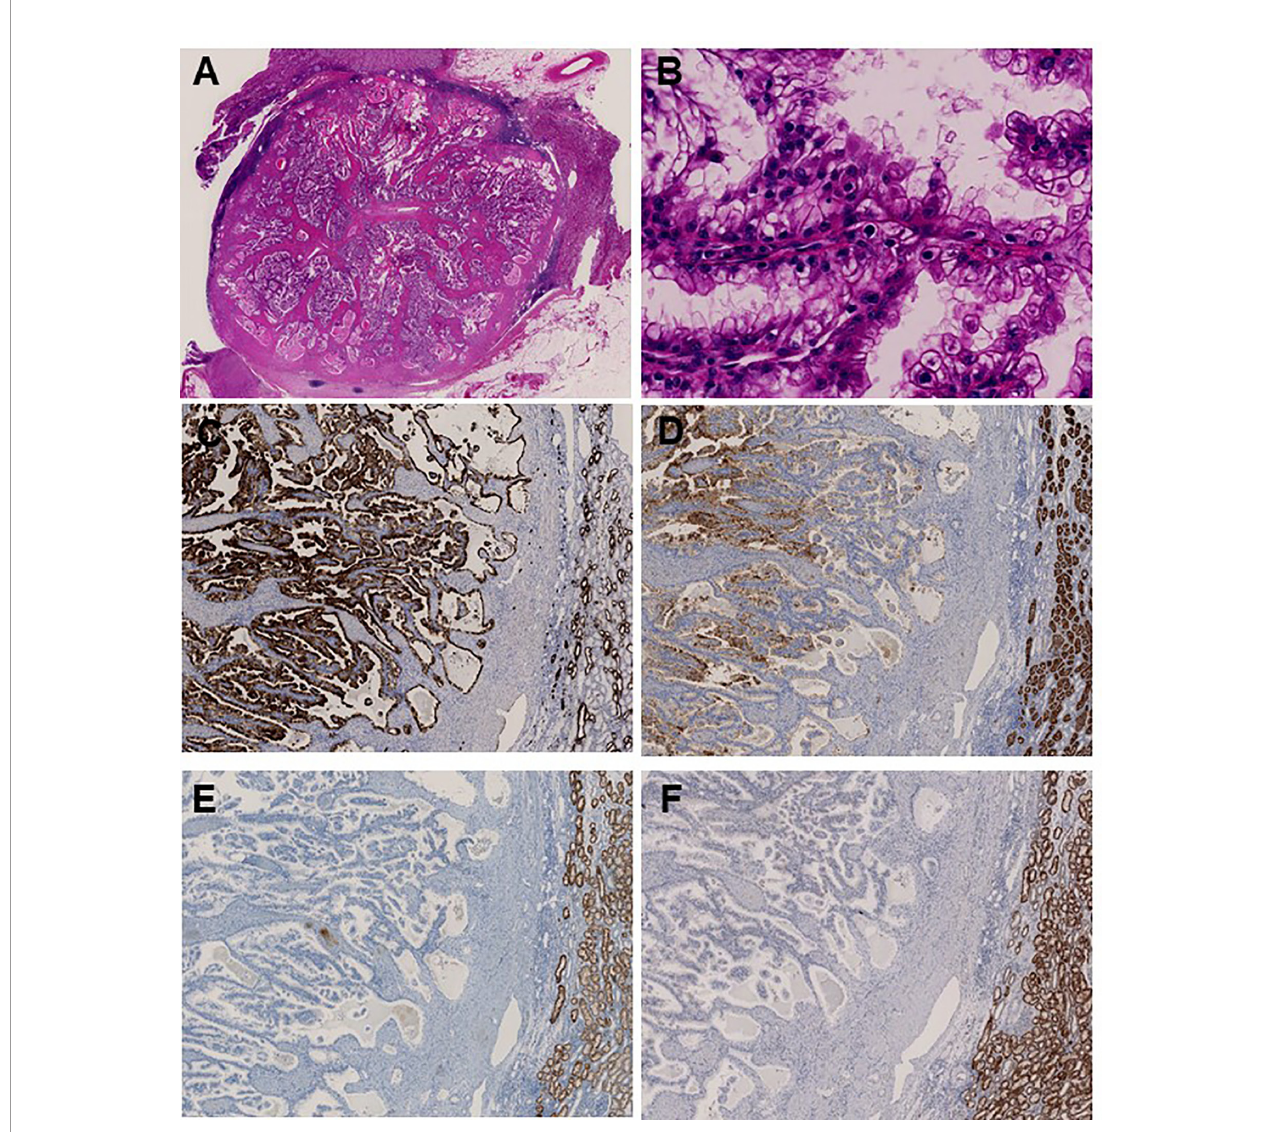
FIGURE 3 | Immunohistochemical analysis identi fi es papillary renal cell carcinoma associated with tuberous sclerosis complex. (A) Main tumor nodule surrounded by thick fi brous stroma on low power; (B) Prominent papillary architecture lined by large clear cells with delicate eosinophilic cytoplasmic thread-like strands, which occasionally appeared more outstanding and aggregated to form eosinophilic globules on high power. Immunohistochemical analysis revealed positive staining for (C) CK7 and (D) CD10, whereas (E) SDHB and (F) AMACR were